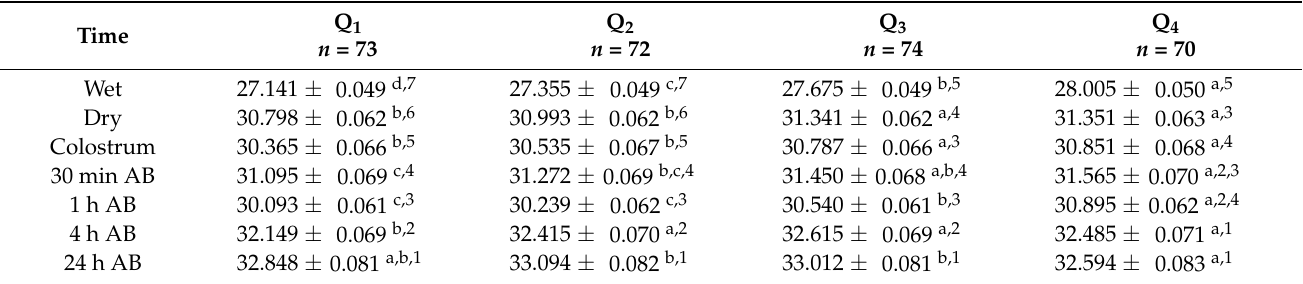
Table 8. Average of the thoracic limb elbow (TLE) window temperature at different times in newborn puppies classified into 4 groups according to